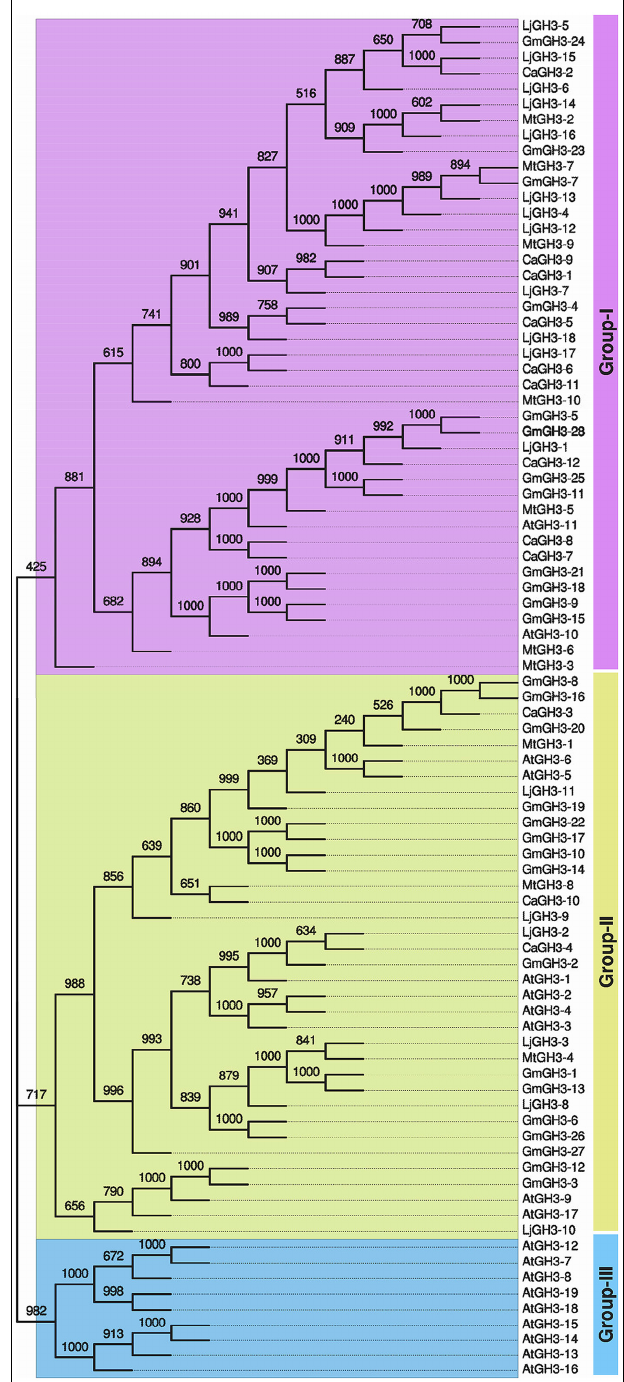
FIGURE 2 | Phylogenetic relationship among chickpea, soybean, Medicago , Lotus, and Arabidopsis GH3 proteins. Multiple sequence alignment of all GH3 proteins from chickpea (CaGH3), soybean (GmGH3), Medicago (MtGH3), Lotus (LjGH3) and Arabidopsis (AtGH3) was performed and tree was generated by UPGMA method. FigTree was used for visualization of the tree. The value at the nodes represents bootstrap values from 1000 replicates. Different groups of GH3 proteins are